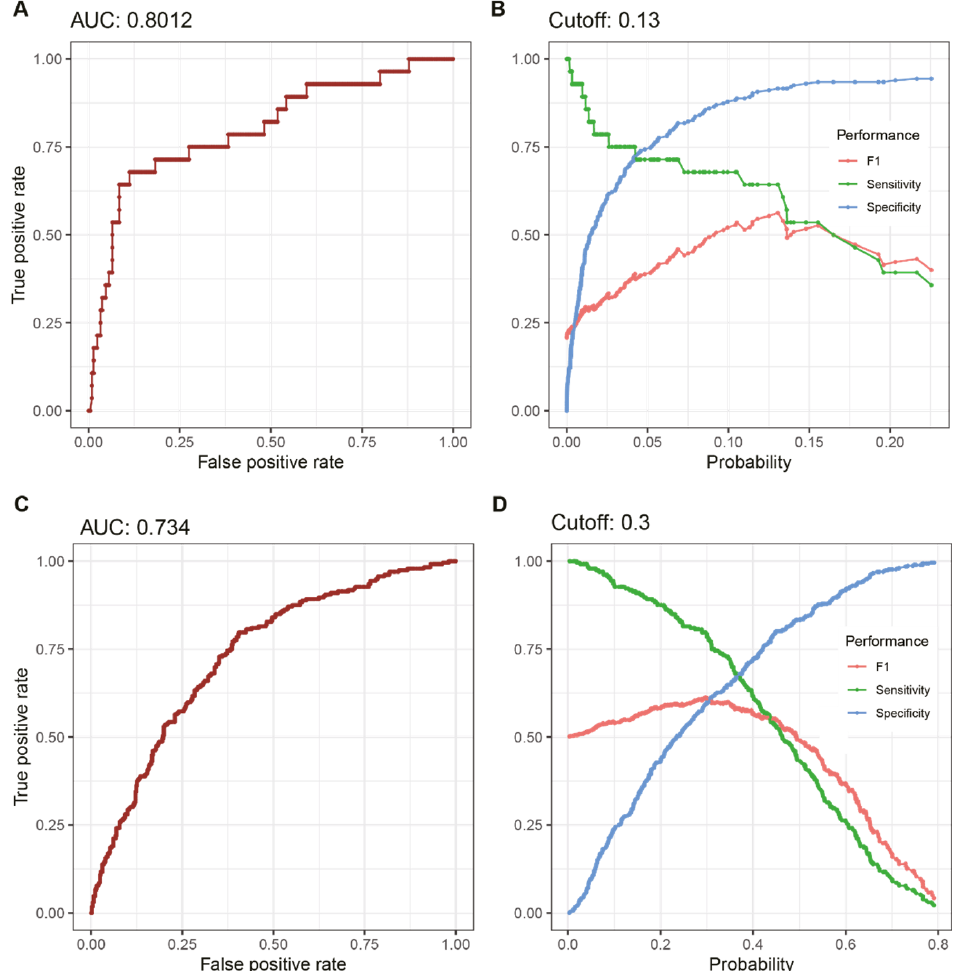
Figure 2. Classification performance of the prediction model for necrotizing fasciitis and osteomyelitis. Among a total of 1581 diabetic foot patients, 70% were randomly assigned as the “training dataset” for feature selection and establishment of the classification model. ( A ) The performance of the LR model was evaluated using the other patients as the “validation dataset.” The area under the ROC curve of the LR model for necrotizing fasciitis was 0.8012. ( B ) The optimal cut off (0.13) for necrotizing fasciitis was determined by the maximum value in the F-score curve based on sensitivity and specificity. ( C ) The area under the ROC curve of LR model for osteomyelitis was 0.734. ( D ) The optimal cut off for osteomyelitis was 0.3. ROC, receiver operating characteristic.